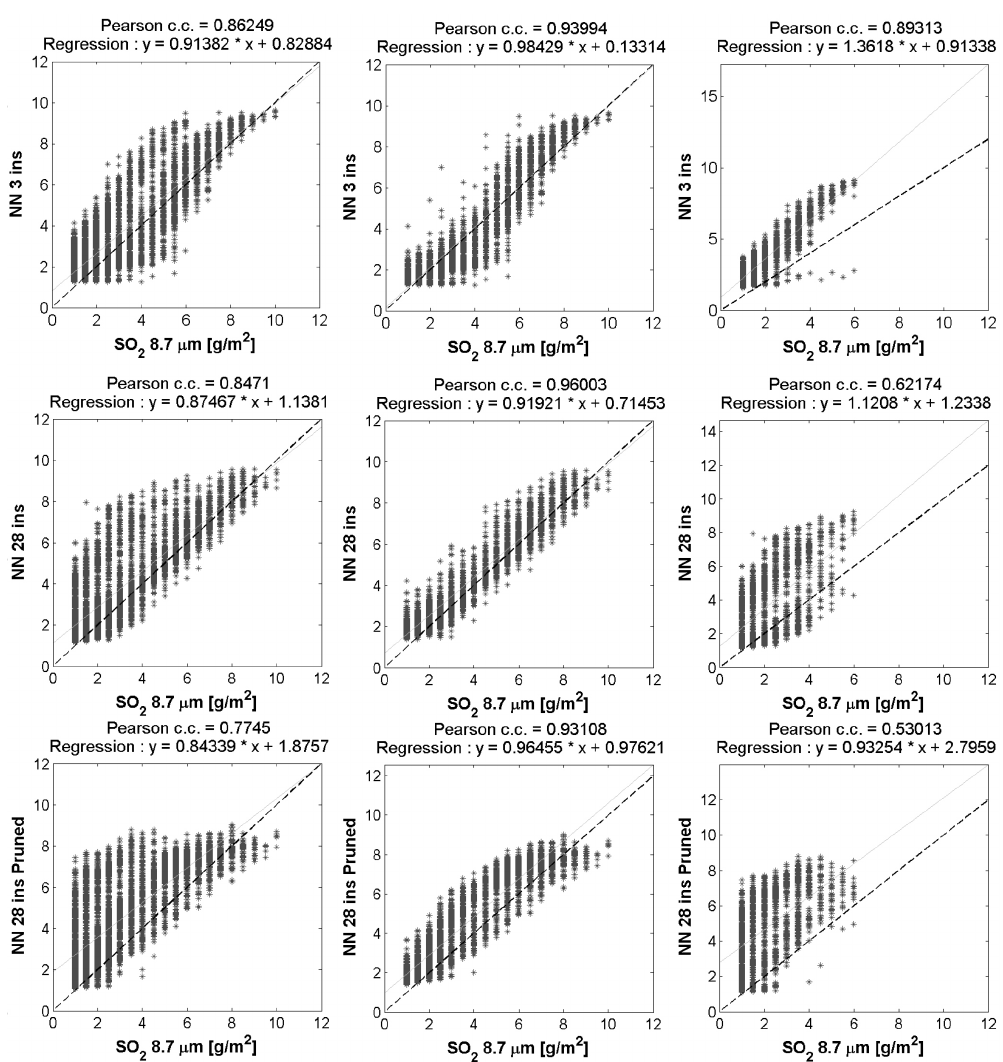
Figure 15. Scatterplots for SO 2 networks, 3 inputs (top row), 28 inputs (middle row) and 28 inputs pruned (bottom row), applied to the validation set of 12 May 2010, 12:55UTC, divided into total patterns (left column), patterns over sea (middle column) and patterns over meteorological clouds (right